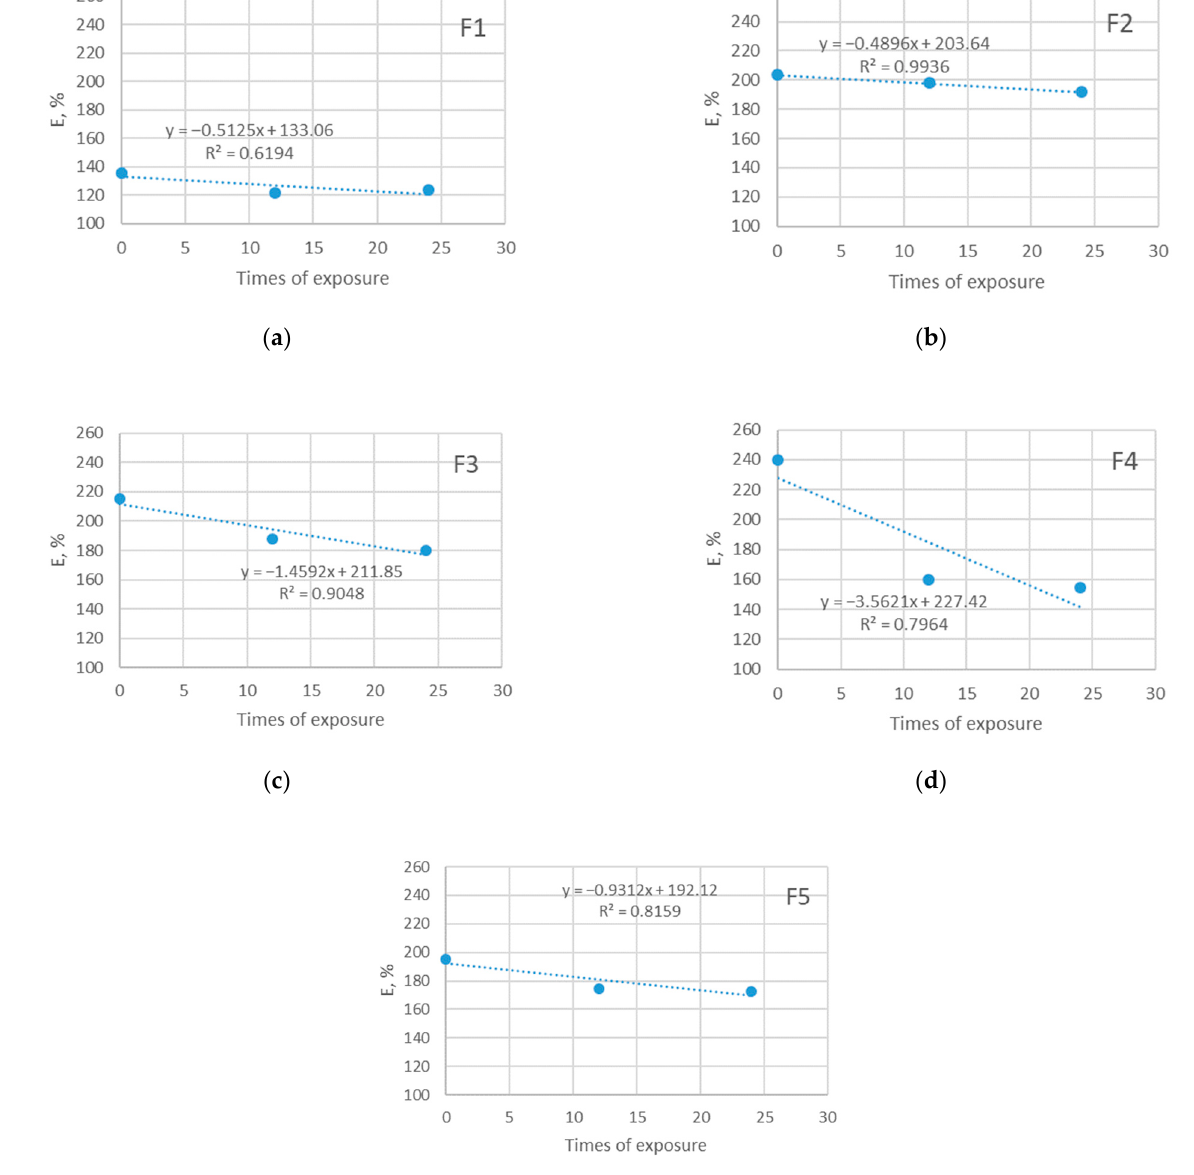
Figure 8. Breaking elongation of five investigated materials exposed in shade: ( a ) F1; ( b ) F2; ( c ) F3; ( d ) F4; ( e ) F5.